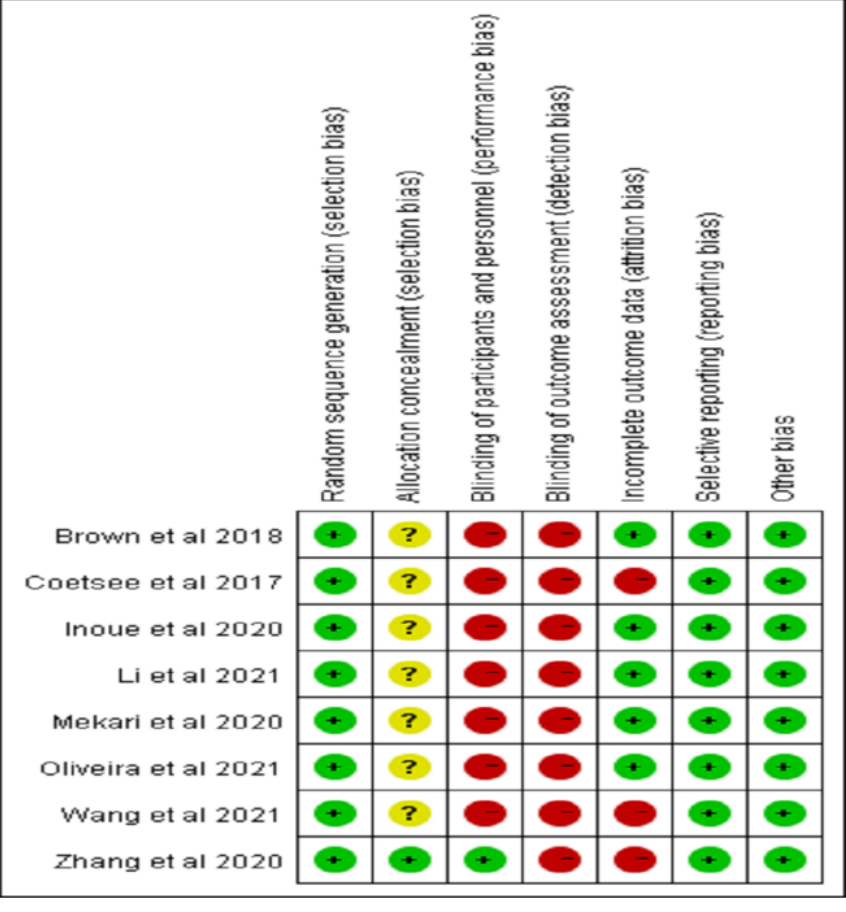
Figure 2. Schematic diagram of risk of bias [24,25,31–36]. Note: Green: Low risk of bias; Yellow: Unclear risk of bias; Red: High risk of bias. Table 1. PEDro Scale scores included in the